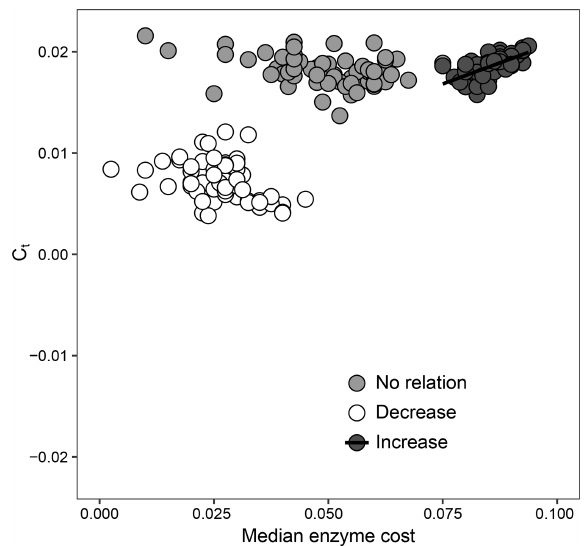
Figure 5. Relationship between the enzyme cost and temperature sensitivity of surviving taxa when the relationship between C t and the enzyme count is set to be positive (increase), negative (de- crease), or nonexistent. Each point represents the value for the me- dian across all surviving taxa for 1 of 59 starting communities.